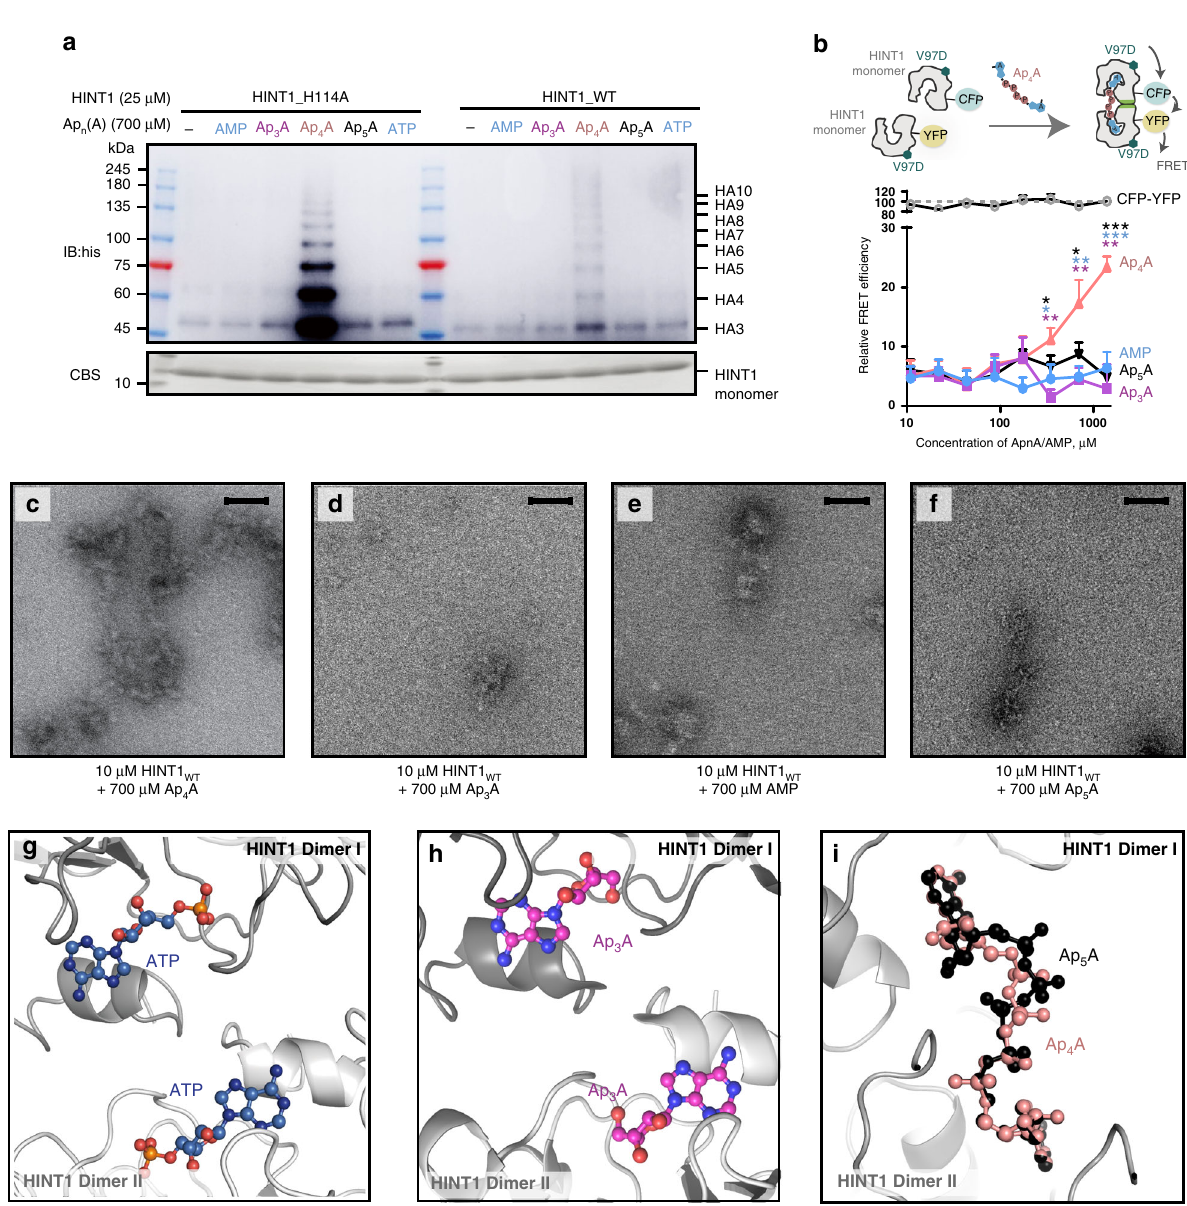
Fig. 5 The length-dependent regulation of Ap 4 A on HAn formation. a EMSA was performed with 25 μ M HINT1 H114A or HINT1 WT incubated with 700 μ M AMP, Ap 3 A, Ap 4 A, Ap 5 A, and ATP separately. Only Ap 4 A could induce the HINT1 polymerization. The experiment was performed three times with similar results. Source data are provided as a Source Data fi le. b FRET assay showing that only Ap 4 A, but not Ap 5 A/Ap 3 A/AMP, could induce the interaction between HINT1 V97D -CFP and HINT1 V97D -YFP. FRET signal between CFP-YFP tandems was measured and set to 100% (error bars represent the SD of